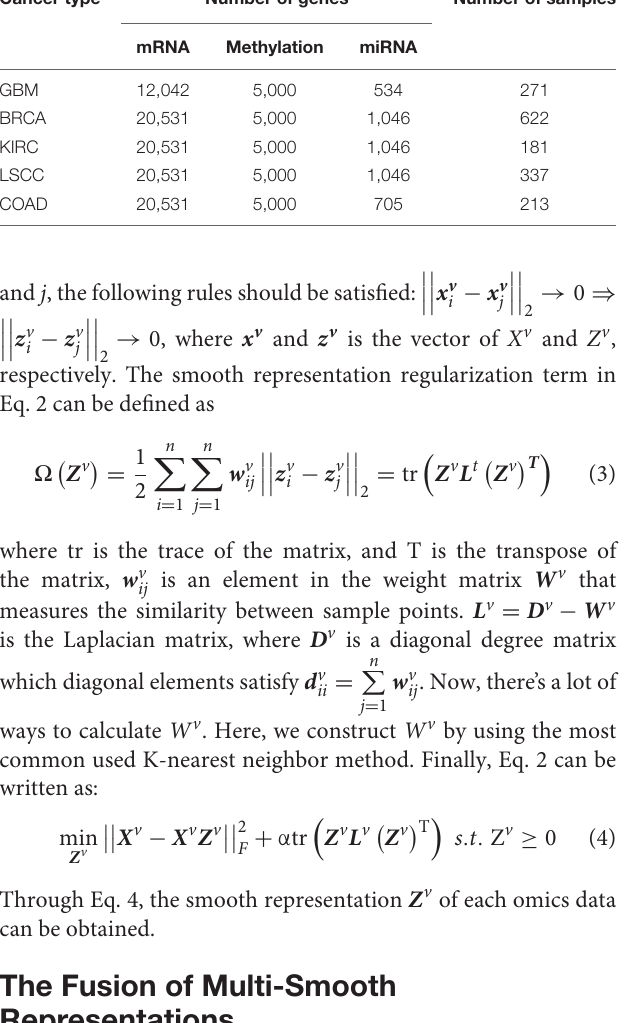
TABLE 2 | Detailed information on five types of cancer multi-omics data sets in Rappoport and Shamir (2018). Cancer type